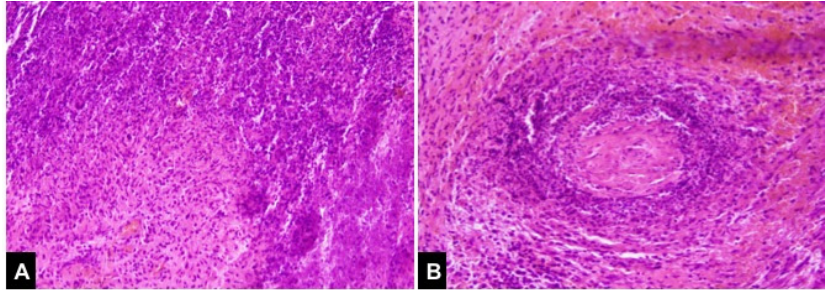
Figure 2. The pathological result demonstrated granulomatous inflammation, geographic necrosis ( A ), and vasculitis ( B ), which were compatible with granulomatosis with polyangiitis. Prednisolone was started as soon as the c-ANCA was found positive at a dosage of 40 mg/day for a month, then tapered gradually with the conjunction of methotrexate use. His vision improved initially but worsened again in the second month despite his cANCA decreasing from 37.2 IU/mL to 4.8 (normal 3.0). Thus, pulse therapy with intravenous methylprednisolone 1000 mg for 3 days and intravenous cyclophosphamide 1000 mg was administrated in the second month since the initial presentation. Another two courses of cyclophosphamide were administrated in the third and fourth months, each with a dosage of 1300 mg. However, his symptom fluctuated as well as his serum ANCA. He thus received rituximab therapy with two doses of 1 gm rituximab, each 14 days apart, followed by maintenance therapy with azathioprine. His cANCA level decreased gradually and turned negative 3 months later after rituximab.